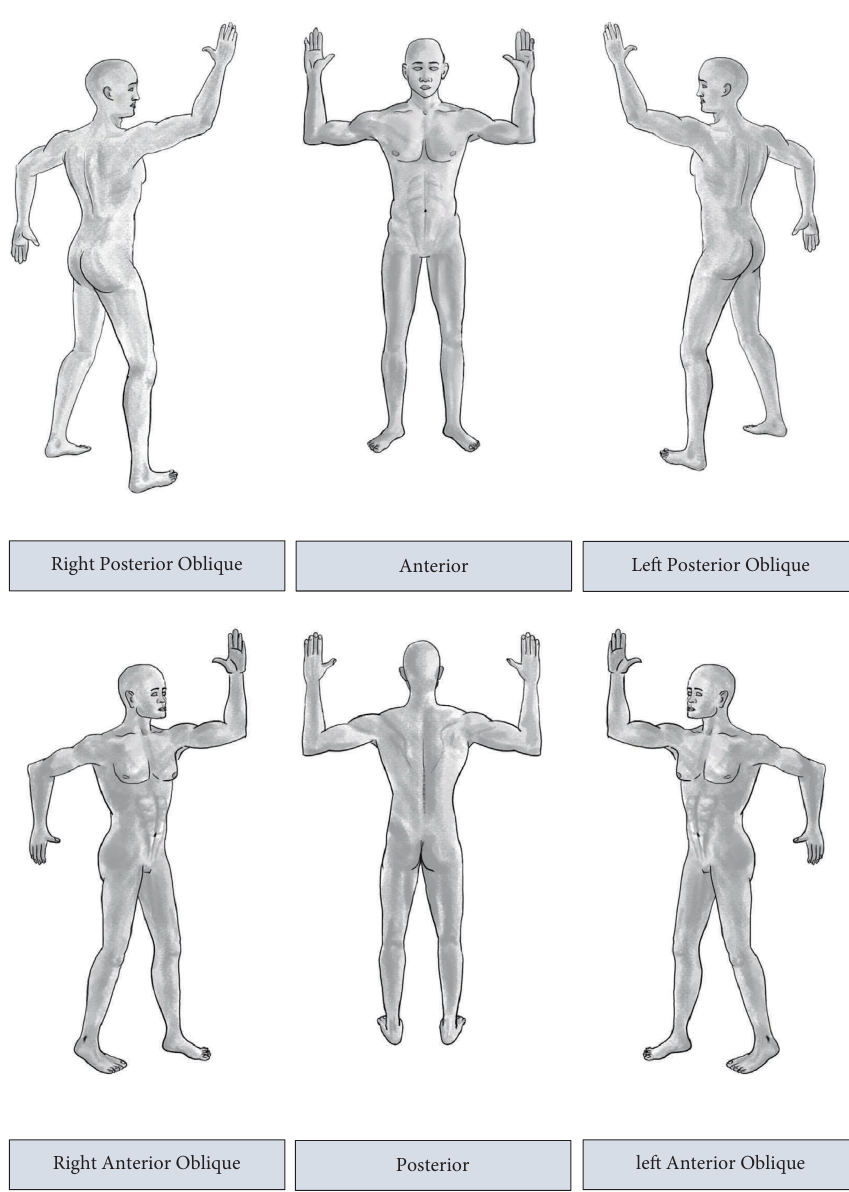
Figure 2: Patient positions for total skin electron beam therapy, 6-feld technique. Te straight anterior, right posterior oblique, and left posterior oblique felds are treated on one day. Te straight posterior, right anterior oblique, and left anterior oblique felds are treated the next day